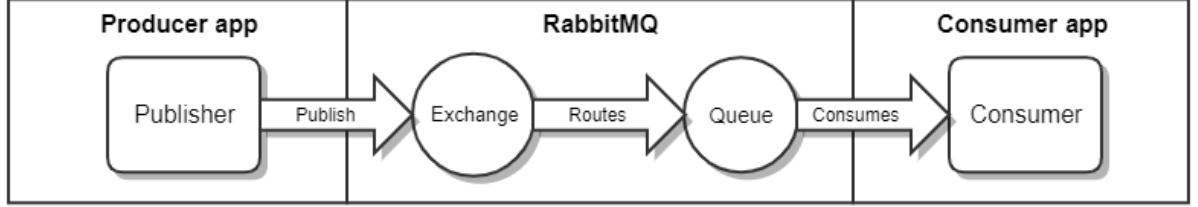
Figure 7. Basic concepts and information flow in RabbitMQ.